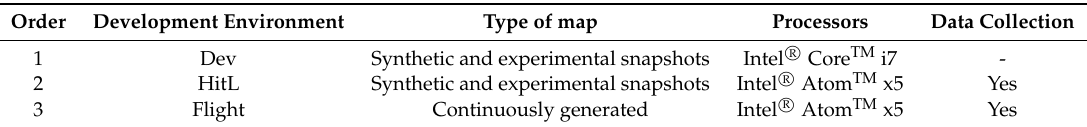
Table 1. Listing of three development environments. Environments are defined by processor choice, the type of map used, and the data collection